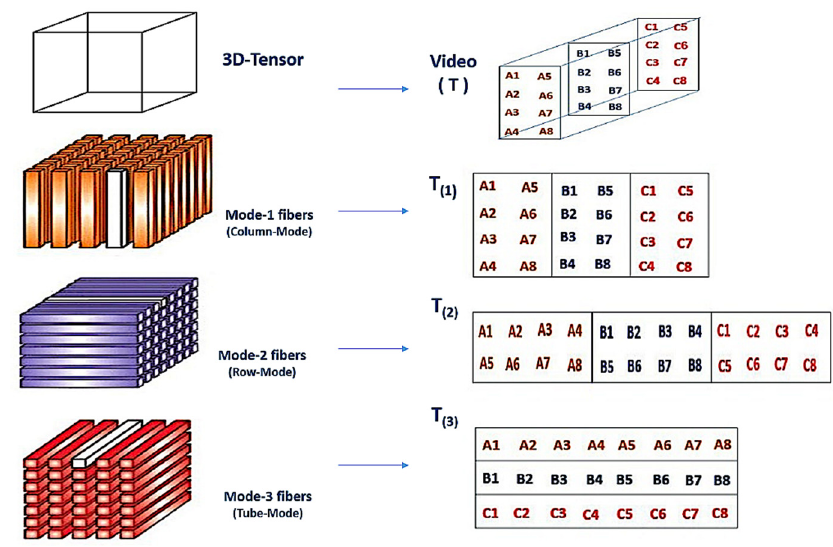
Figure 1. Third-order tensor construction and unfolding matrices.